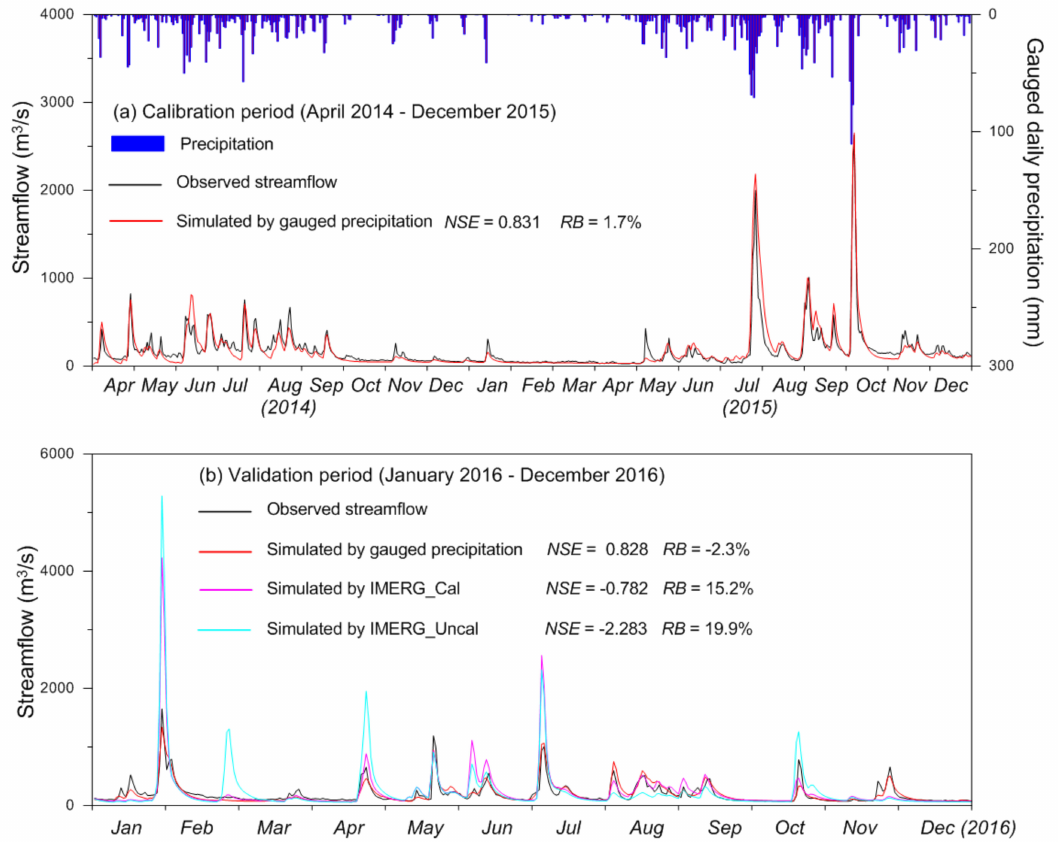
Figure 7. Daily streamflow simulation of the Nanliu River basin (upstream of the Changle station), for calibration and